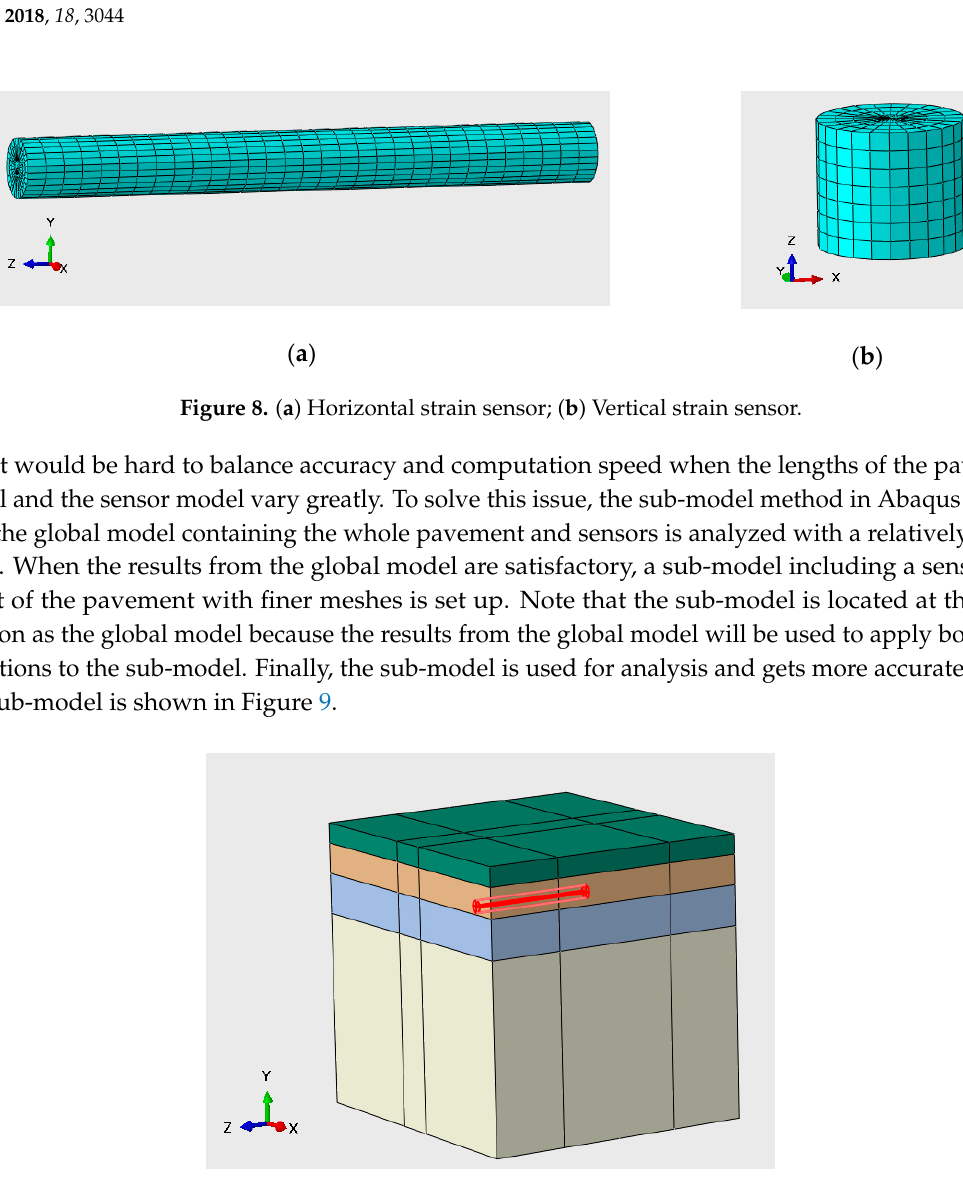
Figure 9. Sub-model with a horizontal strain sensor. The red is a horizontal strain sensor embedded in the lower layer.